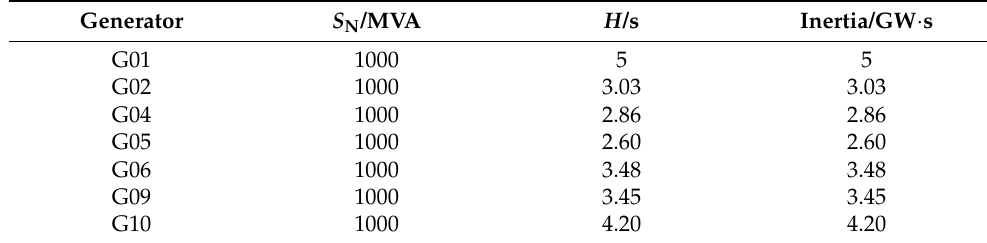
Figure 5. The modified IEEE 39-bus New England system. Table 1. Simulation parameters.